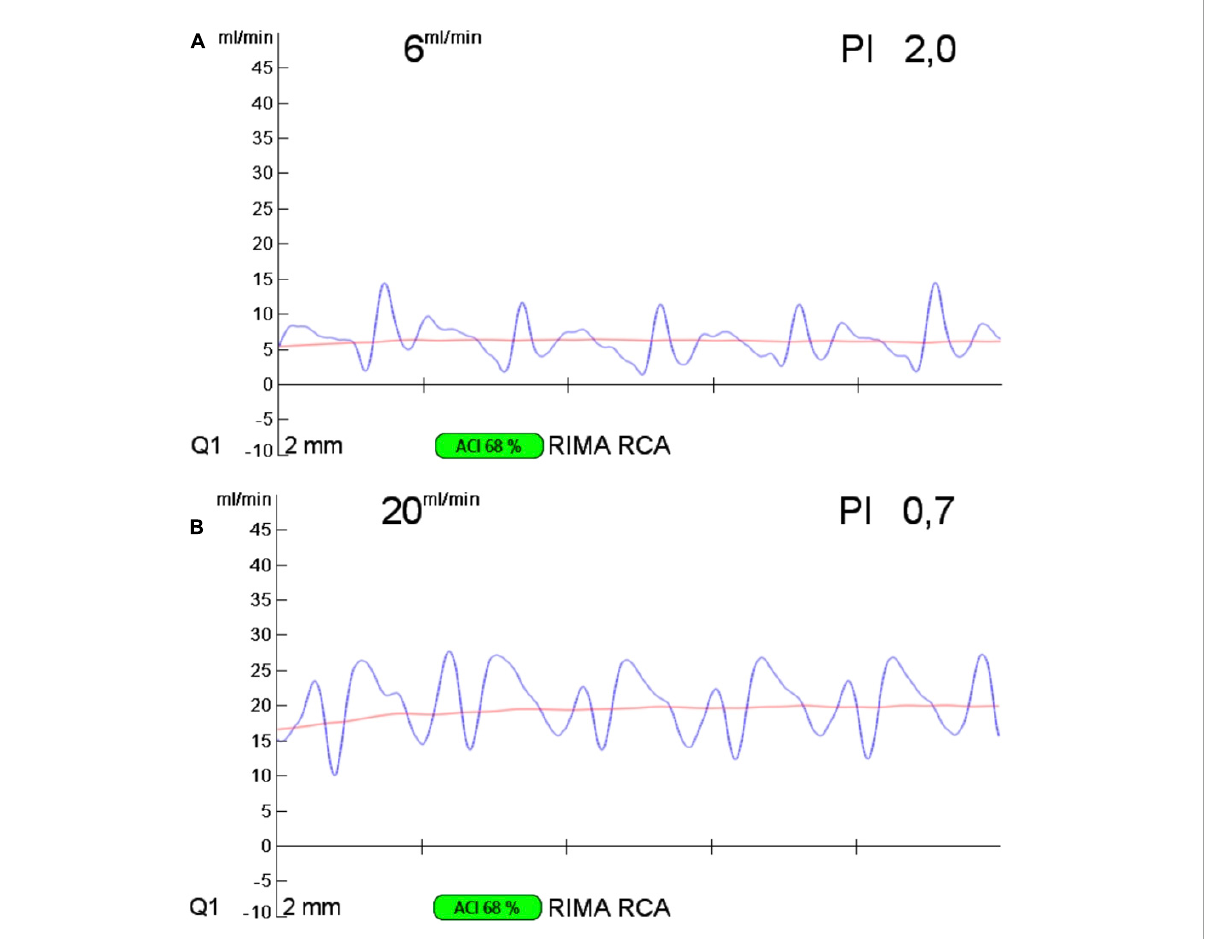
FIGURE3 Transit time flow measurement of the RIMA-RCA bypass graft before (A) and after (B) proximal right coronary artery ligation. RIMA, right internal mammary artery; RCA, right coronary